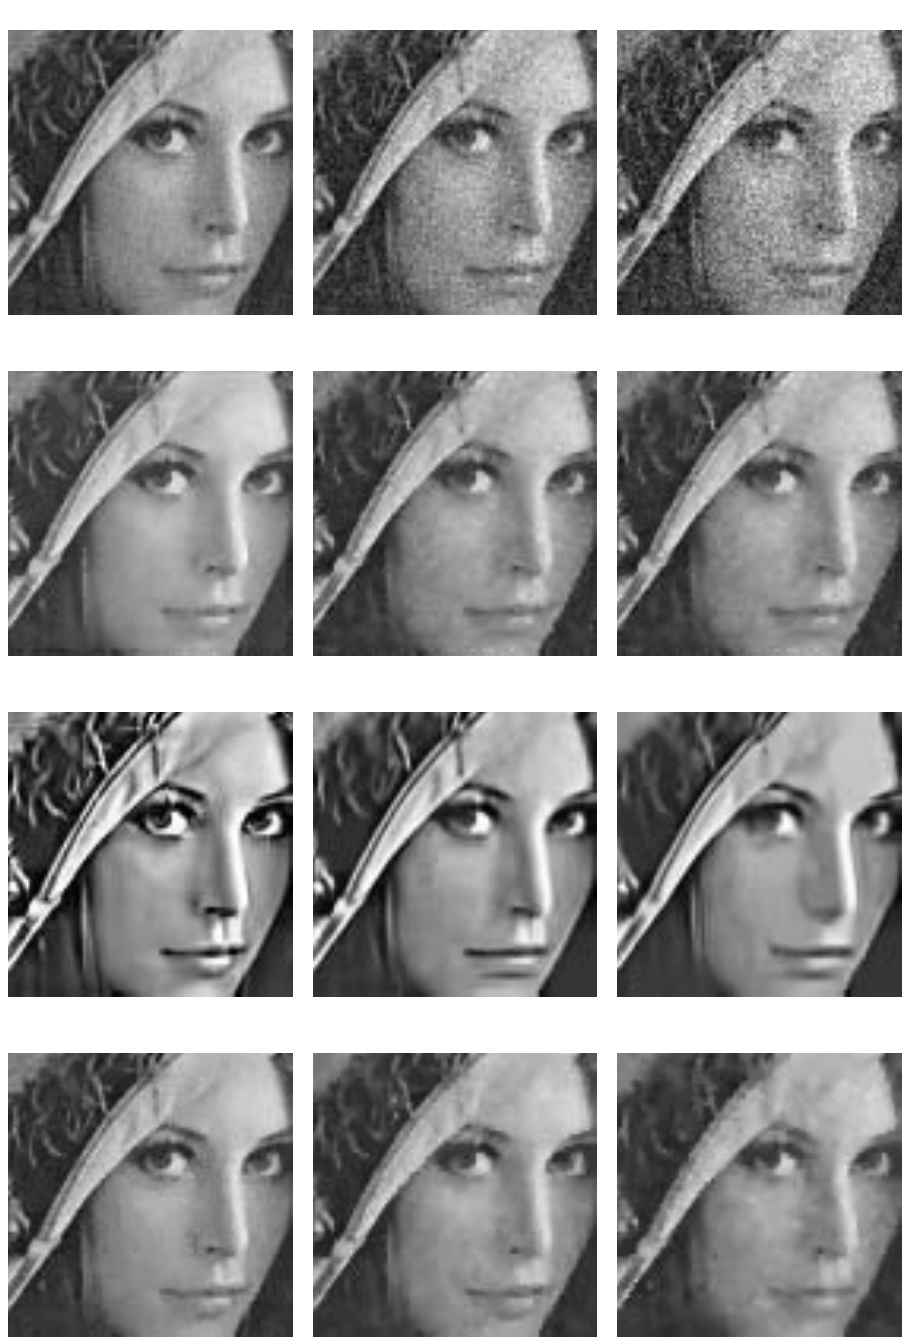
Fig. 12 First row, Lenna image corrupted by Gaussian noise with standard deviations σ = 10, σ = 20 and σ = 30. Second row, the output of Fuzzy Network filter. Third row, output of BM3DShar and in the last one, the output of